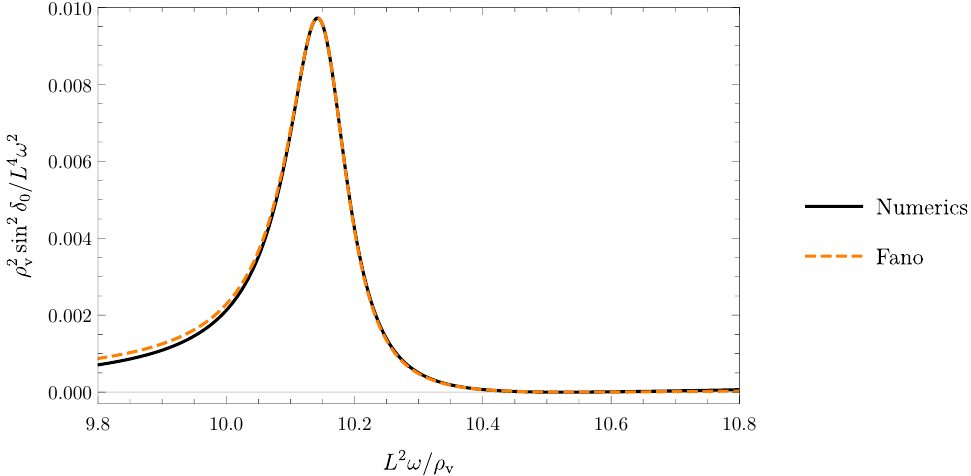
Figure 10. Close-up of the second resonance from the left in (cid:12)gure 9(c), for (cid:13)uctuations of (cid:26) 0 with Q = 0 : 01. The black solid line is our numerical result, while the orange dashed line is the Fano line shape from eq. (5.7) with position ! 0 and width (cid:0) determined from the nearest QNM frequency to be ! 0 (cid:0) i (cid:0) = 2 (cid:25) (10 : 2 (cid:0) 0 : 0573 i ) (cid:26) v =L 2 . Matching the position and height of the peak then gives normalisation (cid:27) 0 (cid:25) 1 : 96 (cid:2) 10 (cid:0) 4 L 4 =(cid:26) 2 and Fano parameter q (cid:25) (cid:0) 6 : 96. v imaginary parts of the associated QNM frequency, respectively, and numerically we (cid:12)nd q (cid:25) (cid:0) 6 :